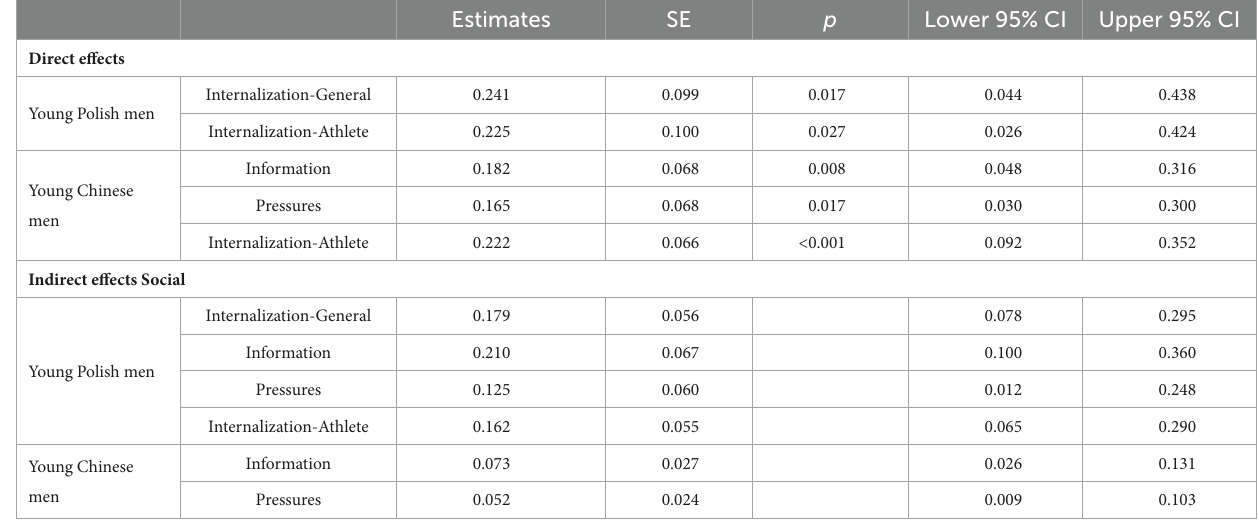
TABLE 3 Model estimates of the four factors of sociocultural attitudes toward the body as direct predictors of obligatory exercise and indirect predictors through the three factors of motivation for physical activity. Estimates SE p Lower 95% CI Upper 95%